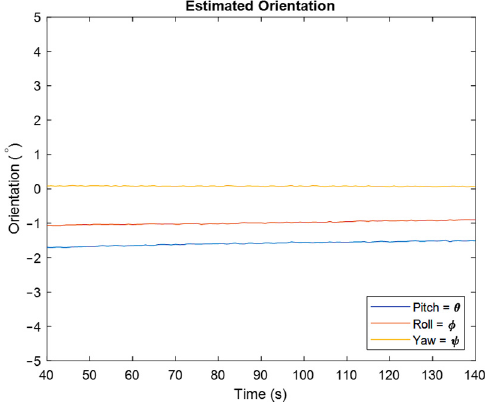
Figure 7. Estimated orientation for the stationary IMU by representing roll, pitch, and yaw